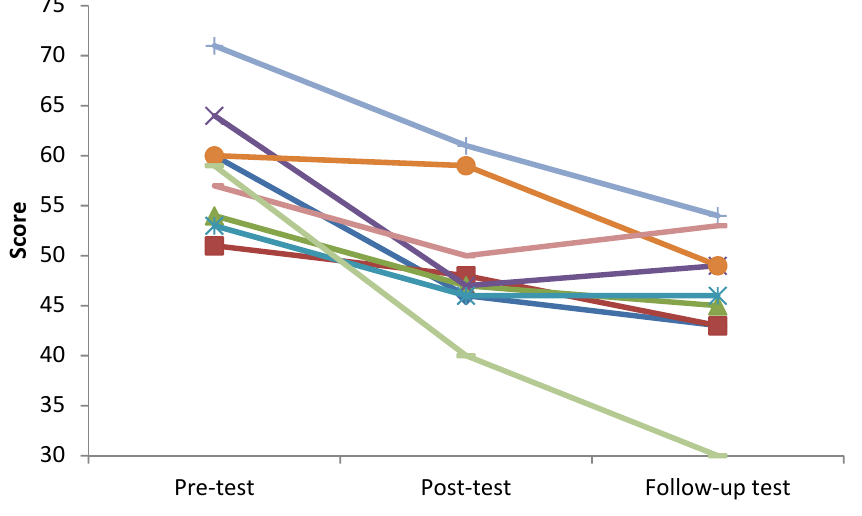
Figure 1. The Total IA Score in the Experimental Group ( n = 9).